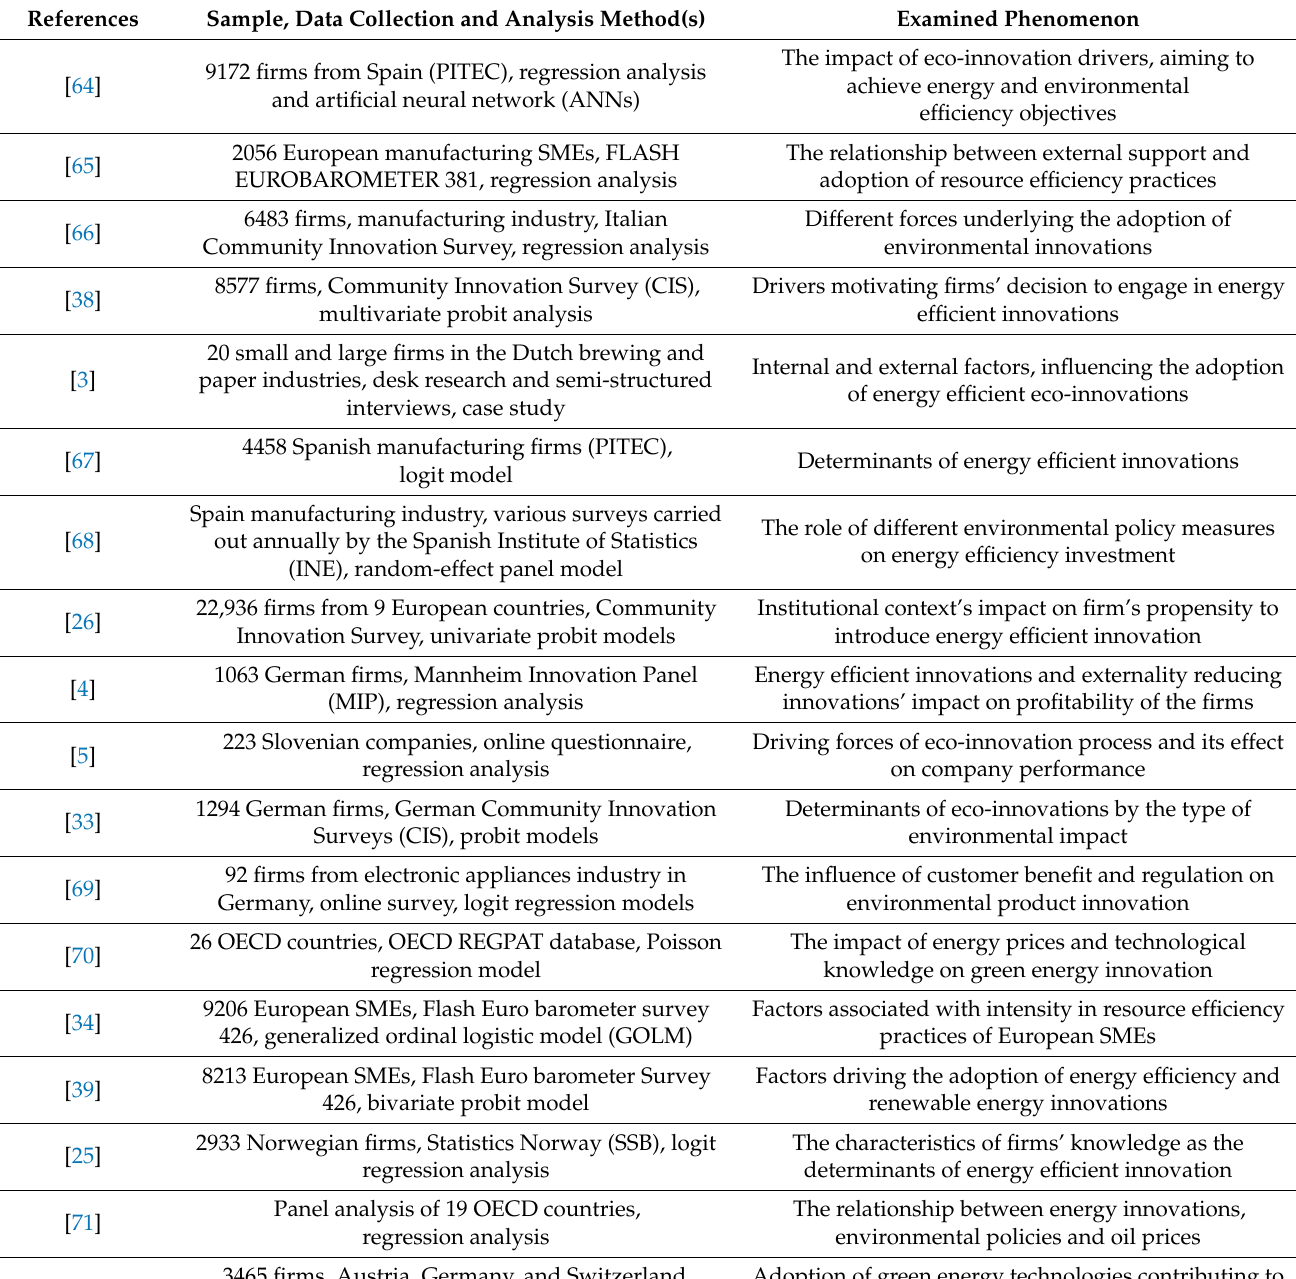
Table 3. Summary of reviewed articles on the determinants of energy efficient